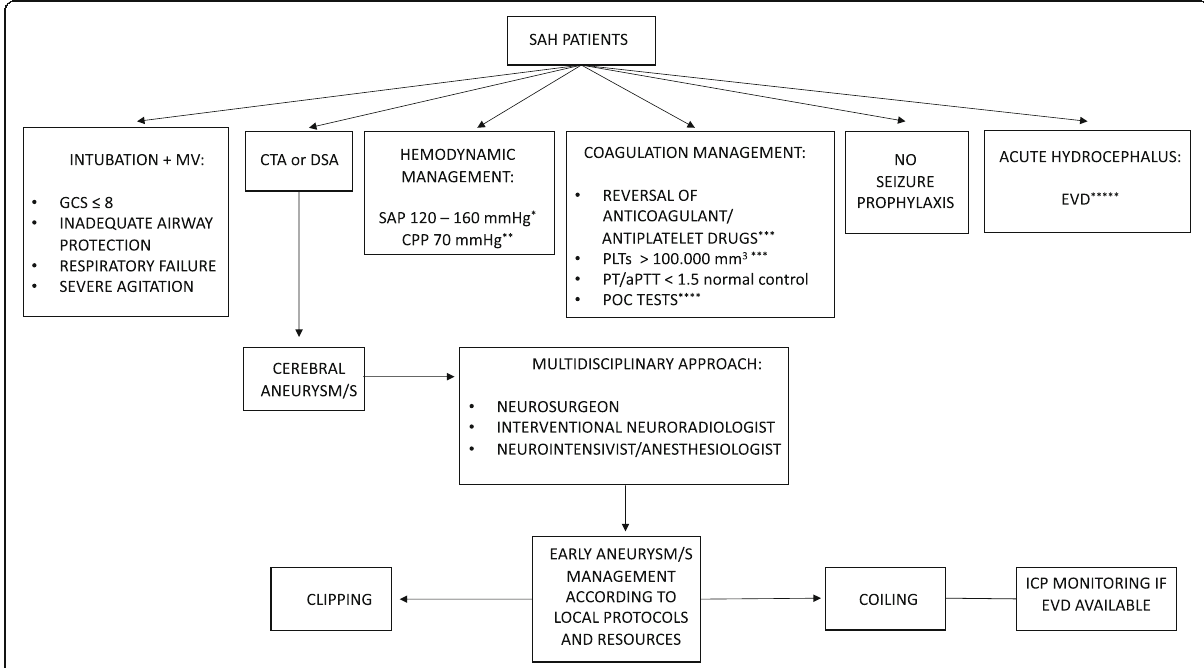
Fig. 1 Consensus flow-chart. * according to patient ’ s clinical history (i.e., arterial hypertension, etc.) and/or radiological signs of intracranial hypertension. ** in case of ICP monitoring; for an accurate CPP estimation the arterial transducers need to be zeroed at the level of the tragus. *** SAH patients candidates for neurosurgical intervention. **** if available, to assess and optimize the coagulation function in salvageable SAH patients taking the NOACs and/or antiplatelet drugs. ***** before aneurysm treatment, in case of intracranial hypertension, drain small volumes of CSF to reduce the risk of rebleeding. SAH subarachnoid hemorrhage, CTA computed tomography angiography, DSA digital subtraction angiography, POC pint-of-care, EVD external ventricular drain, ICP intracranial pressure, GCS Glasgow coma scale, CPP cerebral perfusion pressure, SAP systolic arterial pressure, PLTs platelets, PT prothrombin time, aPTT activated partial thromboplastin time, MV mechanical